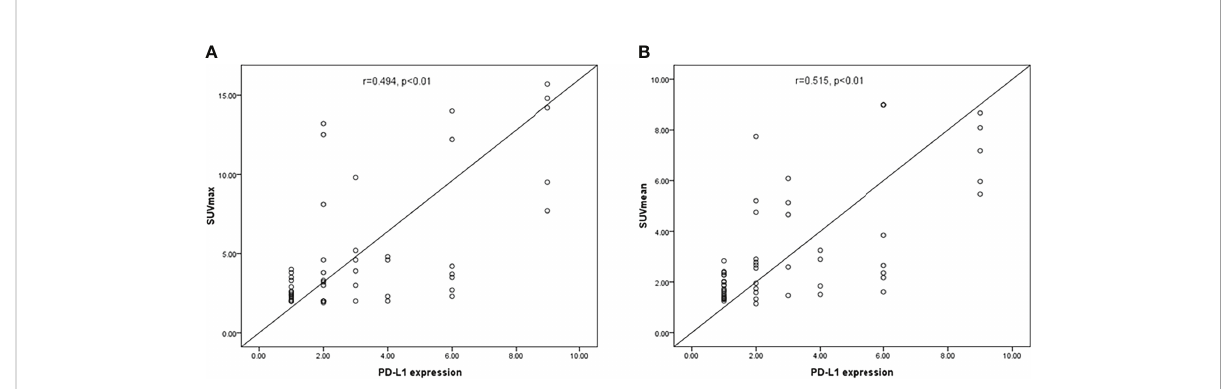
FIGURE 2 The correlation between PD-L1 levels and SUVmax and SUVmean in CCRCC. (A) SUVmax correlated positively with PD-L1 levels (P < 0.01). (B) A signi fi cant positive correlation was found between PD-L1 levels and SUVmean (p <